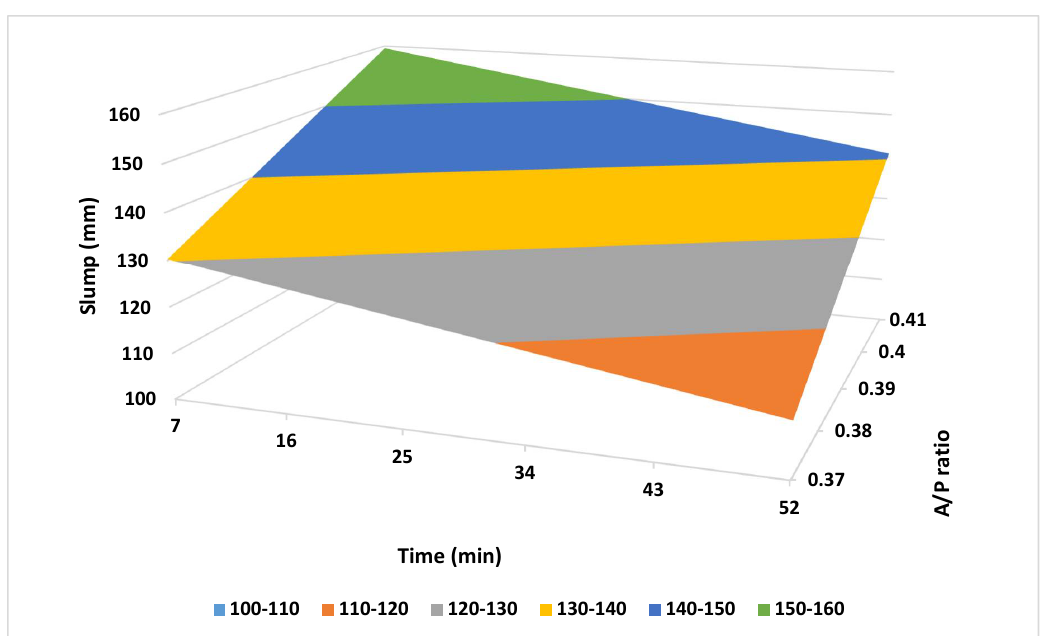
Figure 10. Spread diameter as a function of A/P ratio and time.